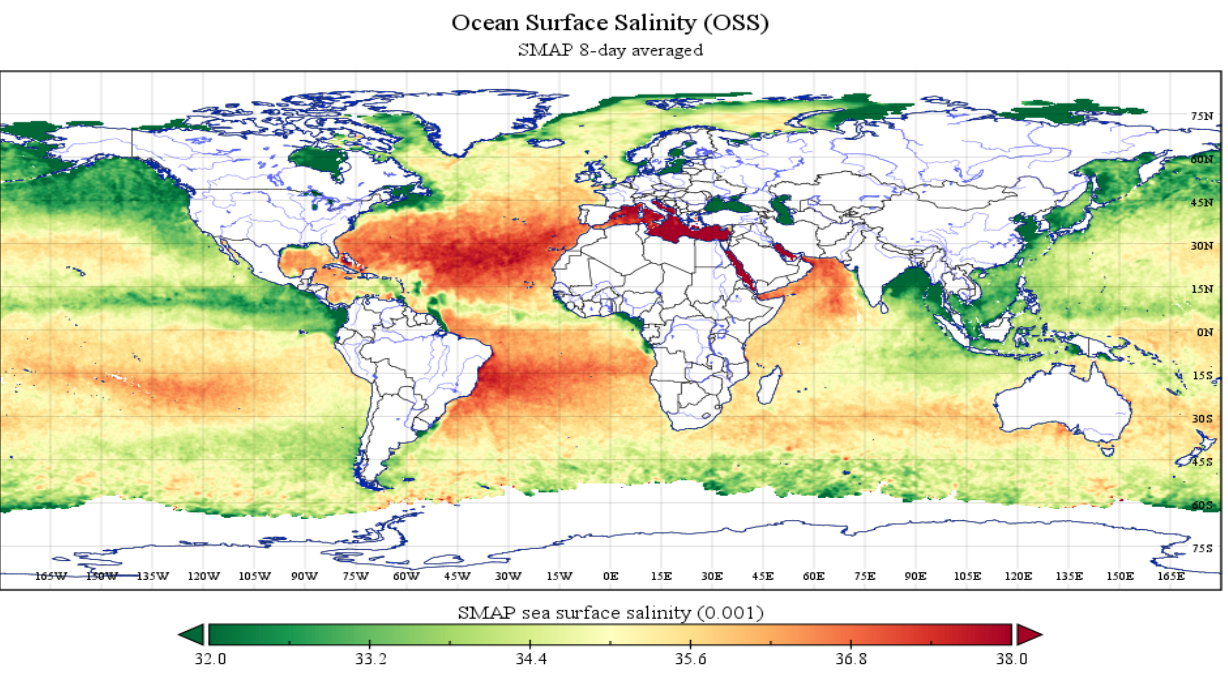
Figure 8. Ocean surface salinity map derived from 8 ‐ day averaged SMAP observations.